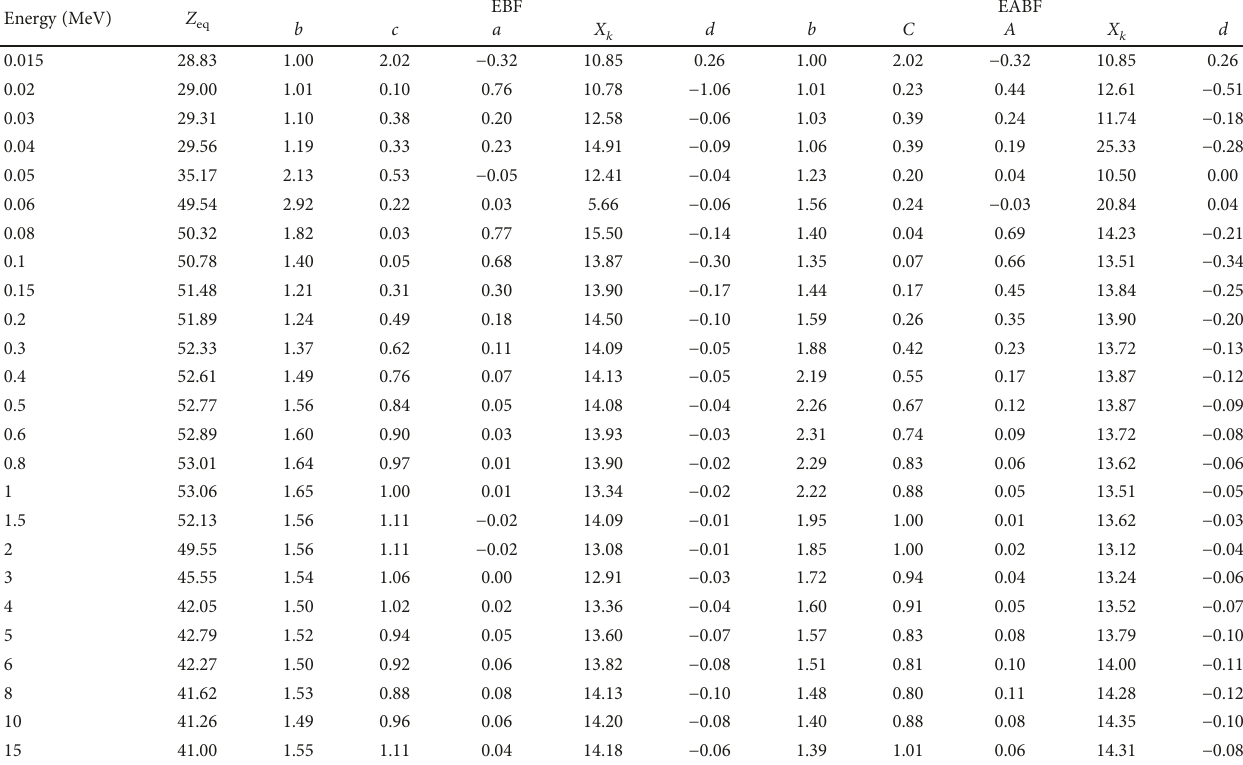
) and G-P exposure (EBF) and energy absorption (EABF) buildup factor coe ffi cients of GAGOC. eq